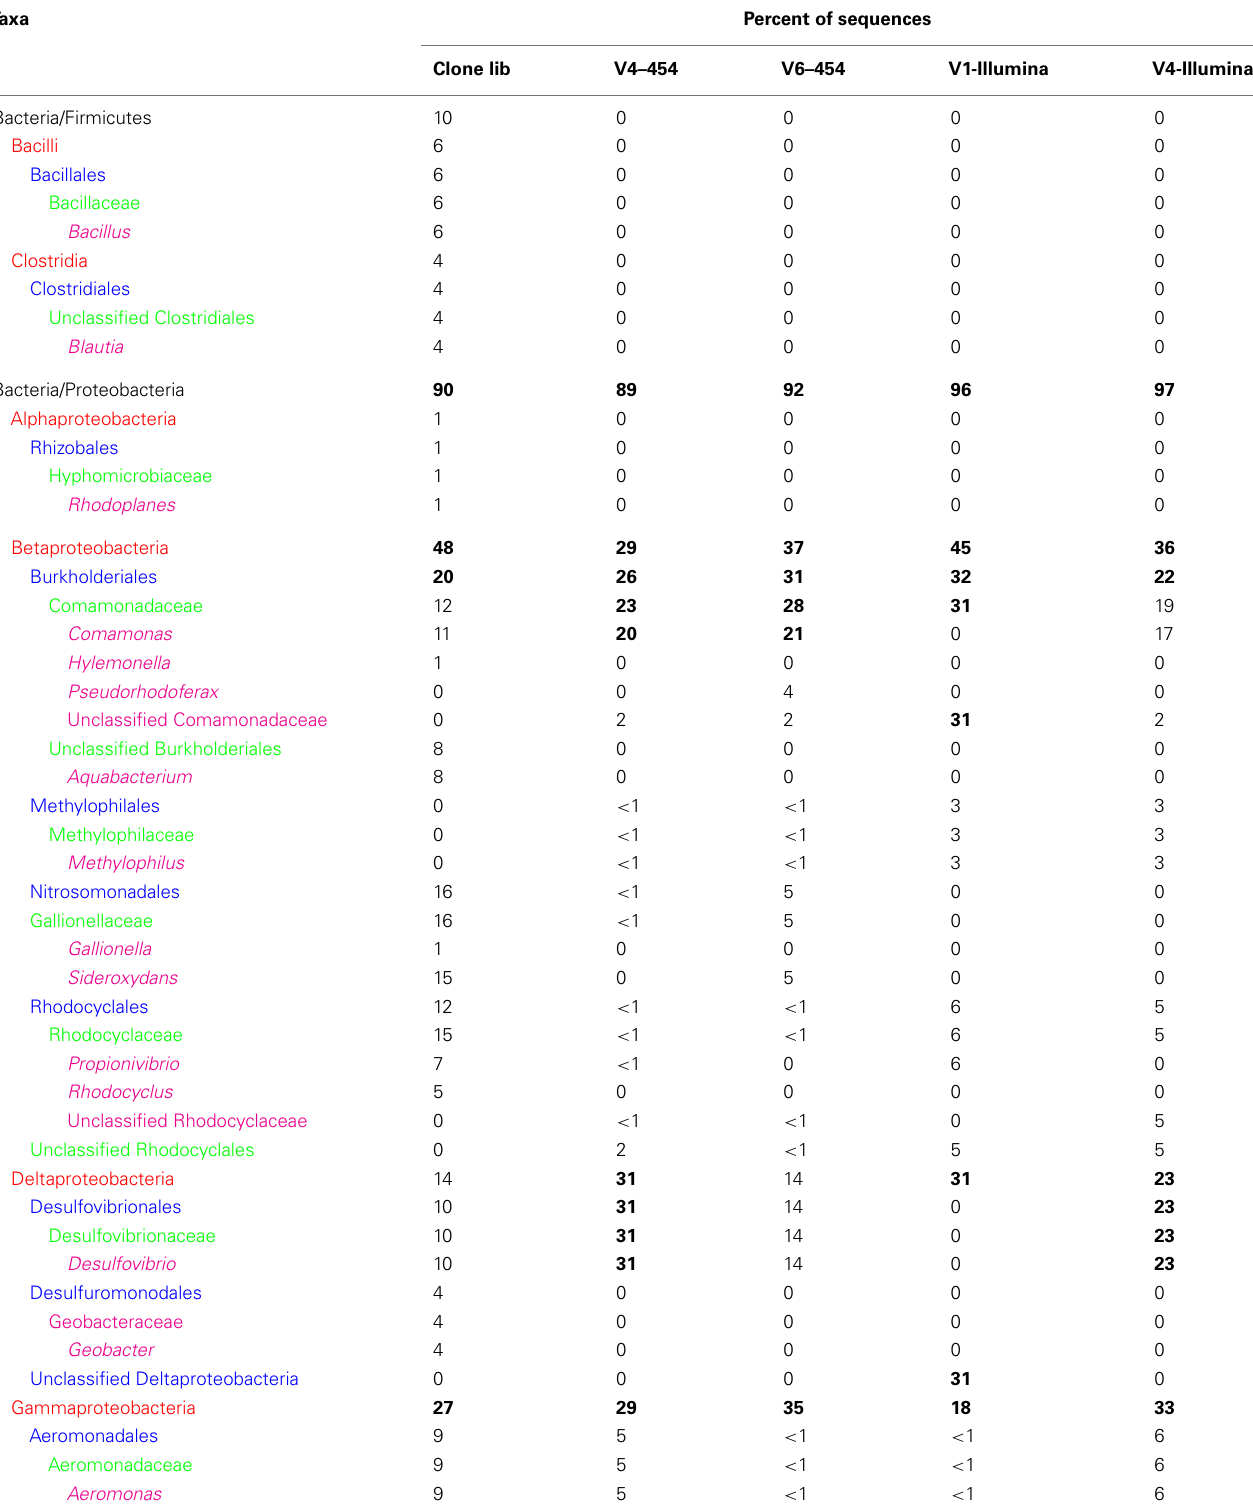
Table 5 | Relative abundance of different phylogenetic taxa obtained by cloning and sequencing and pyrosequencing of 16S rRNA genes from site 7 (puffball) using different sequencing platforms and primer